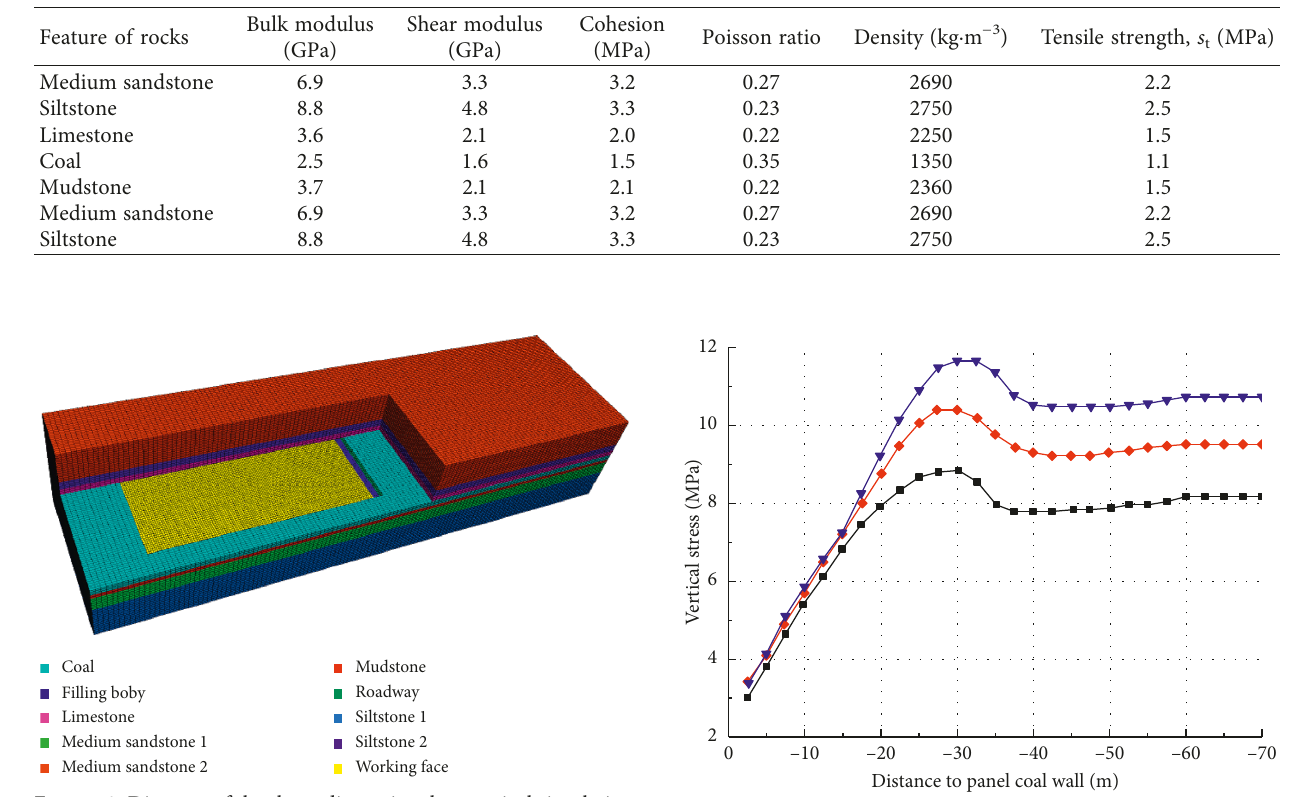
Table 2: Material parameters.